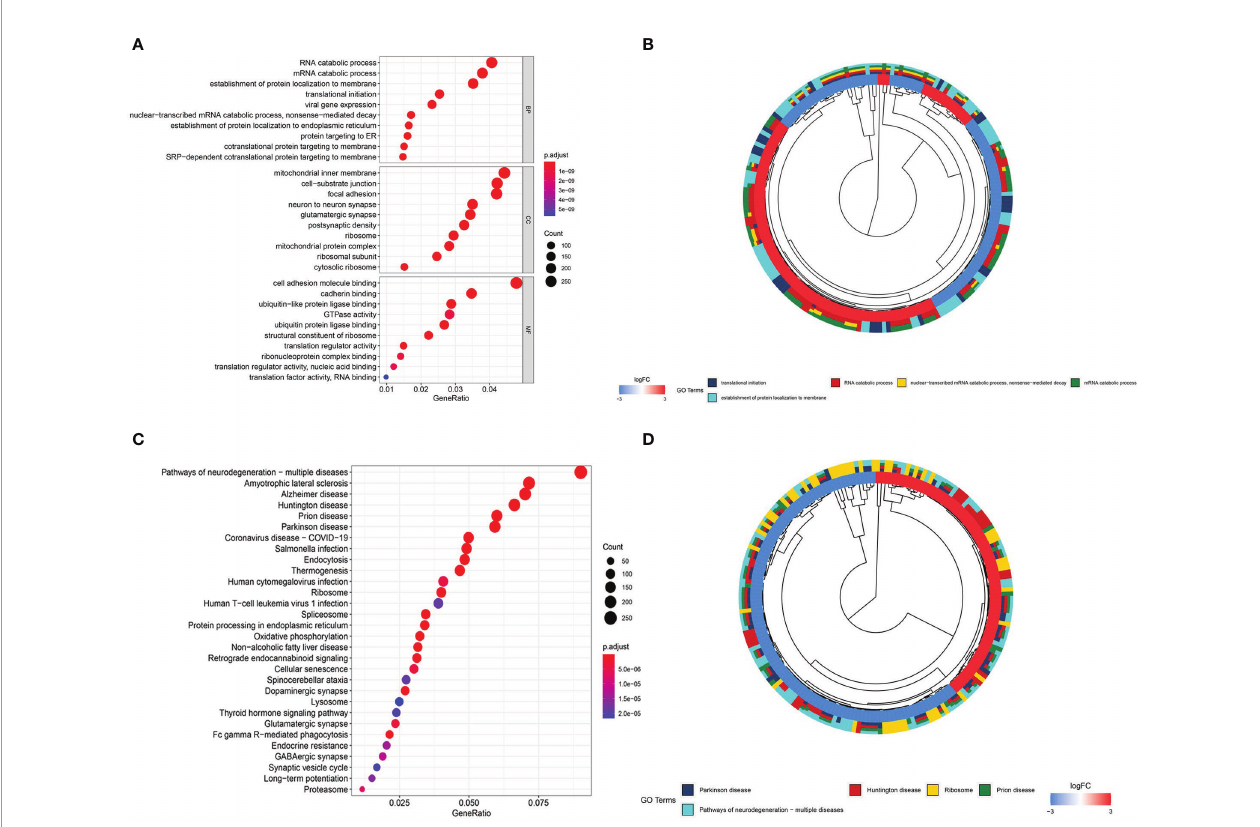
FIGURE 4 | Gene Ontology (GO) and Kyoto Encyclopedia of Genes and Genomes (KEGG) enrichment analyses. (A) Bubble plot of GO enrichment analysis. (B) Circle plot of GO enrichment analysis. (C) Bubble plot of KEGG enrichment analysis. (D) Circle plot of KEGG enrichment